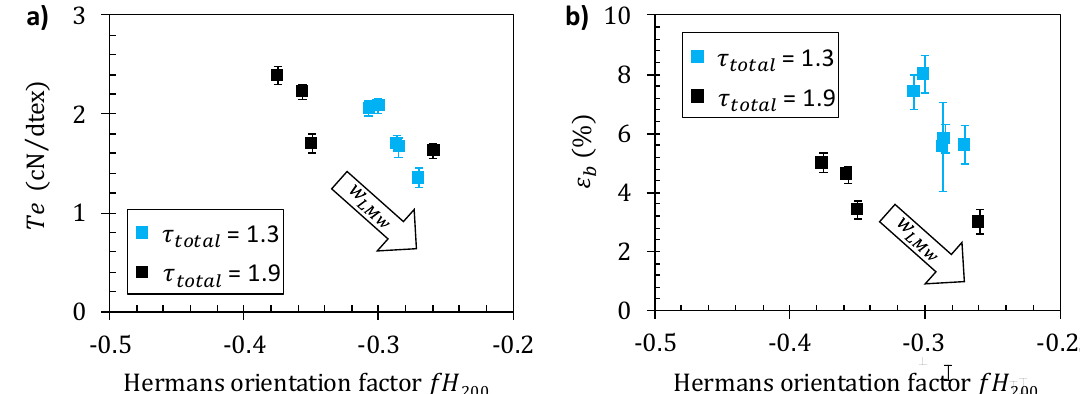
Figure 9. Evolution of fiber tenacity (stress-at-break) Te ( a ) and strain-at-break ε b ( b ) with the Herman’s orientation factor f H 200 at stretching ratios of 1.3 and 1.9, with different chitosan low-molecular weight content w LMW.